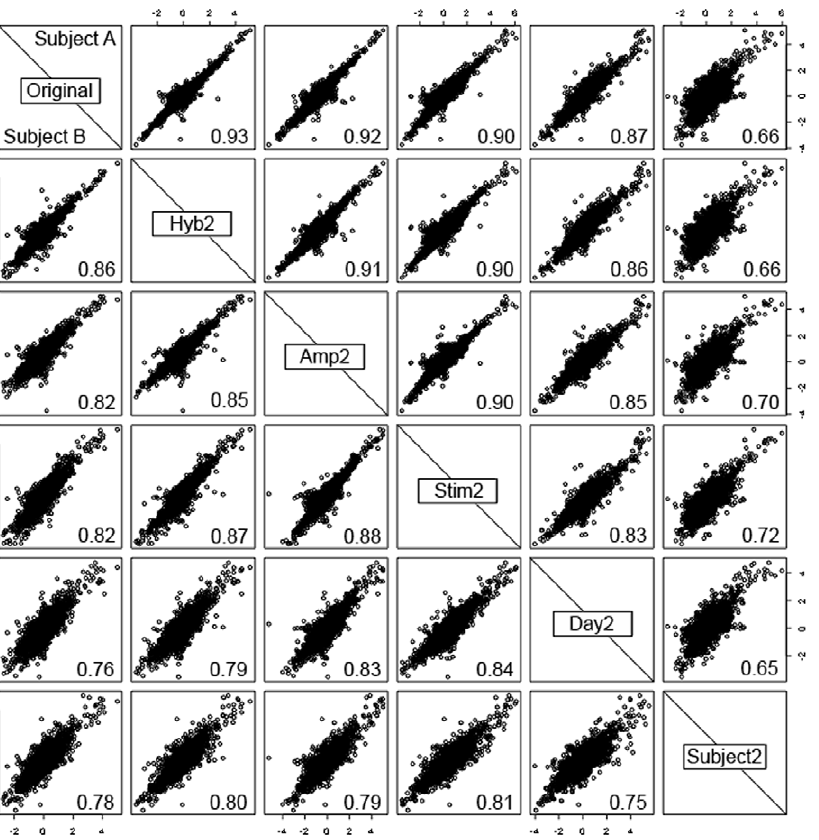
Figure 2. Matrix of scatterplots showing log 2 ratios for replicate hybridisations at each level of the experiment. The fold changes for each sample are plotted against those for each of the other samples for gene expression after stimulation with LPS for two subjects: subject A (top right of diagonal) and subject B (bottom left). Comparisons are made at different levels of the experiment: hybridisation (Hyb2), amplification (Amp2), stimulation (Stim2), day (Day2) and subject (Subject2). Correlation coefficients between each pair of samples are shown in the bottom right of each box.